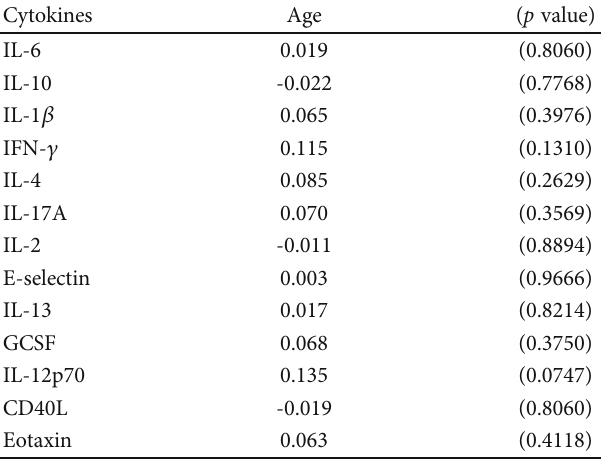
Table 3: Correlation between cytokines and ages of woodworkers.